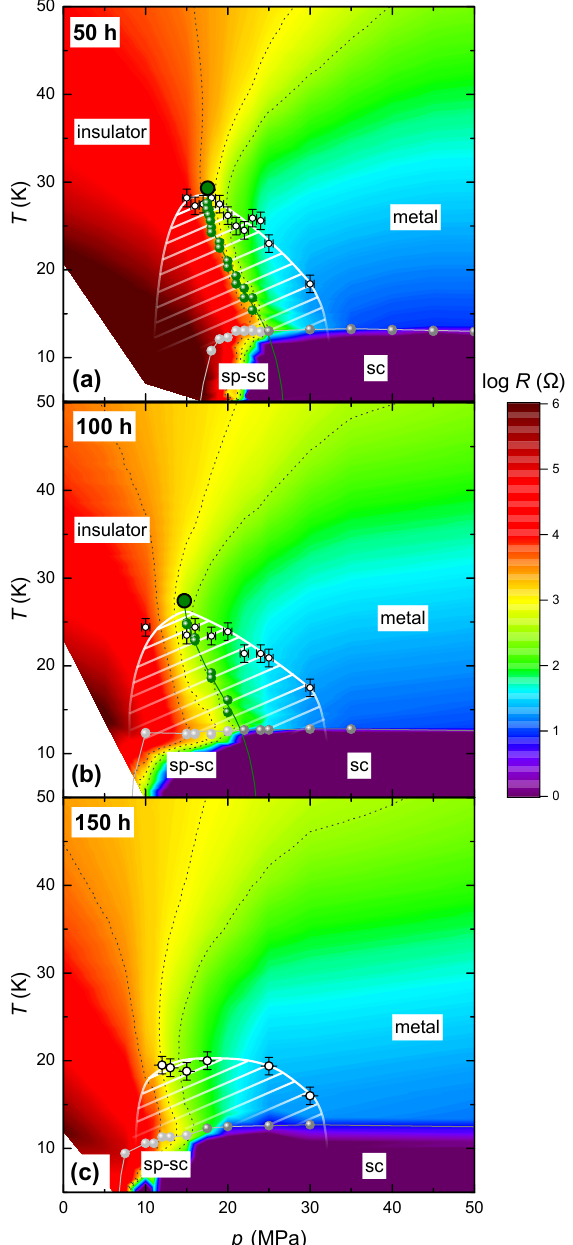
Figure 7. Experimentally determined T - p phase diagrams for a κ -(BEDT-TTF) 2 Cu[N(CN) 2 ]Cl crystal of batch #5-7 after exposure to X-ray for 50h ( a ); 100h ( b ) and 150h ( c ). Data were extracted from the resistance R measurements presented in Figure 5. Green symbols in ( a , b ) represent the first-order transition line extracted from cooling as well as warming experiments, the black-edged big green circle marks the second-order critical endpoint. After exposure to X-ray for 150h ( c ) no discontinuities in R ( T , p ) indicating a first-order phase transition could be resolved. White circles indicate the temperature, below which a sizable hysteresis between warming and cooling was observed. White hatched area is a guide to the eye for the hysteresis region, delimited by the white circles. Dark grey symbols mark the entrance into a spurious superconducting (sp-sc) state. Light grey symbols indicate the transition into a bulk superconducting (sc) state. Lines are guide to the eyes. The background shows a contour plot of log ( R ( T , p ) / Ω ) . Dashed lines indicate three constant-resistance lines with log ( R / Ω ) = 2.5 Ω , log ( R / Ω ) = 3 Ω and log ( R / Ω ) = 3.5 Ω